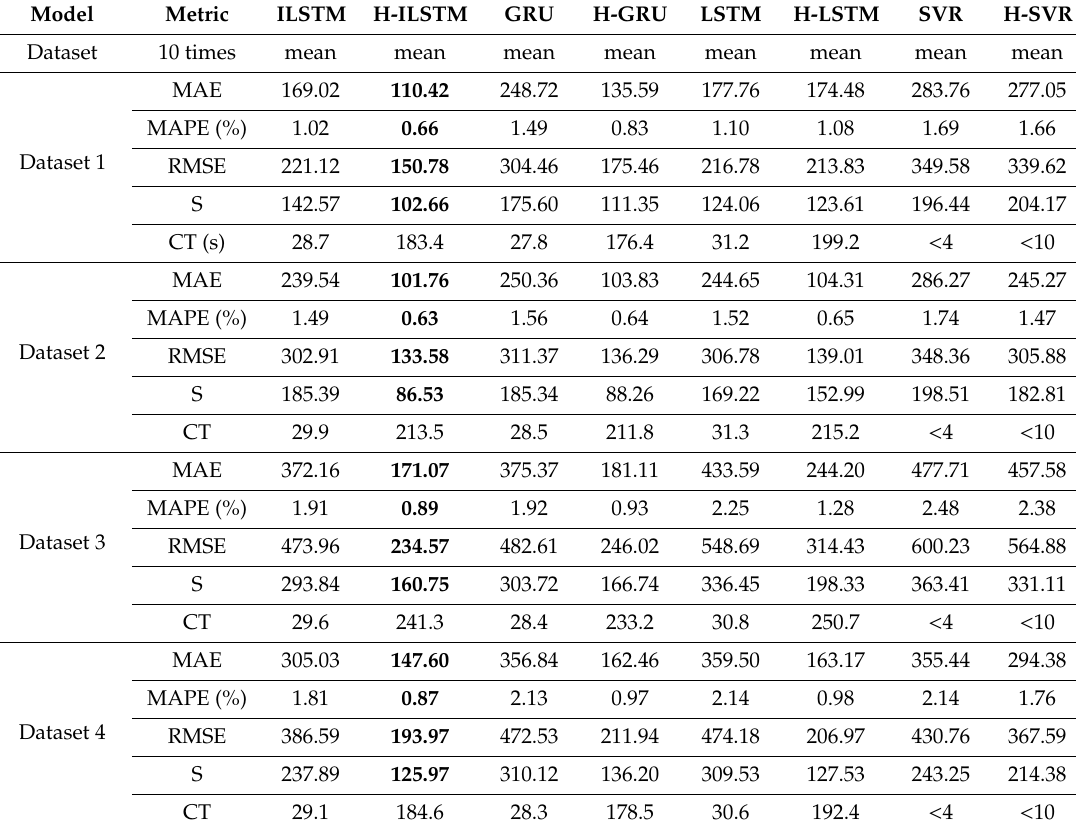
Figure 11. Coefficient of determination by different methods for dataset 1. Table 6. One-step prediction result of load. (The bold words in the table represent the best prediction results among the eight models).